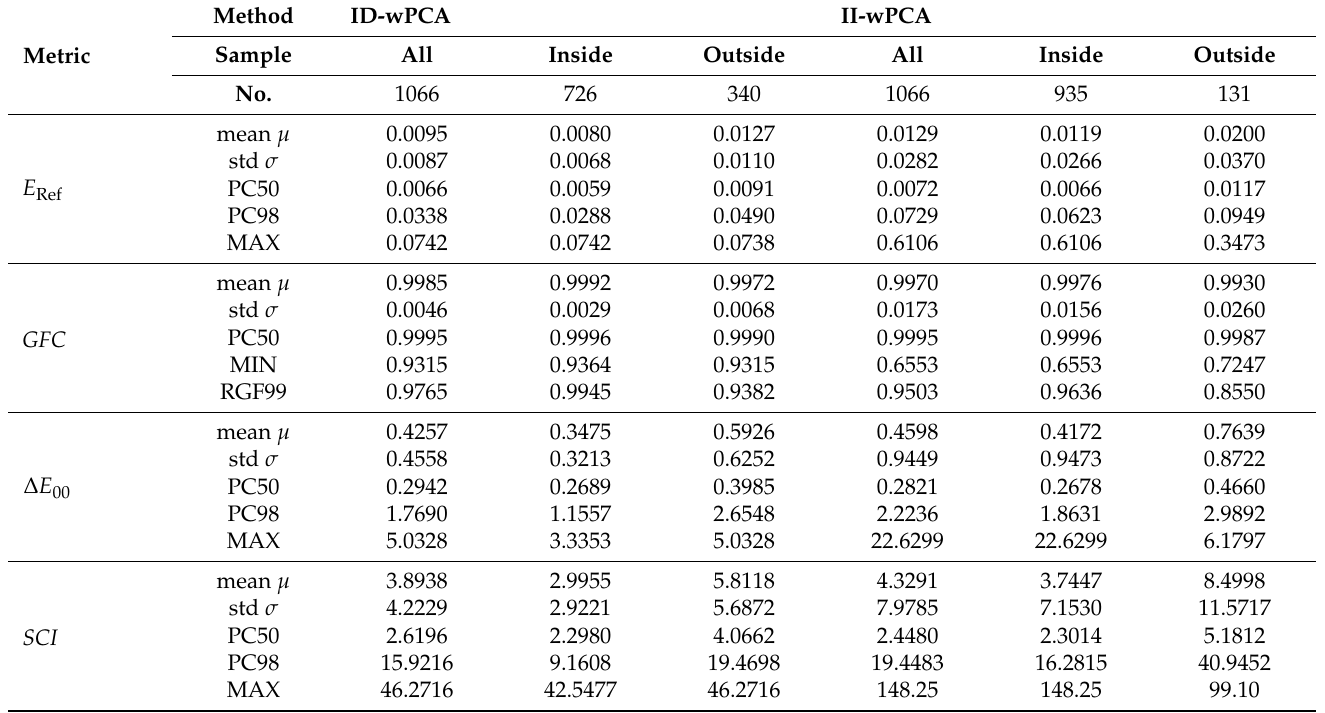
Table 4. Assessment metric statistics for the test samples using the ID-wPCA and II-wPCA methods, where the camera is RGBF